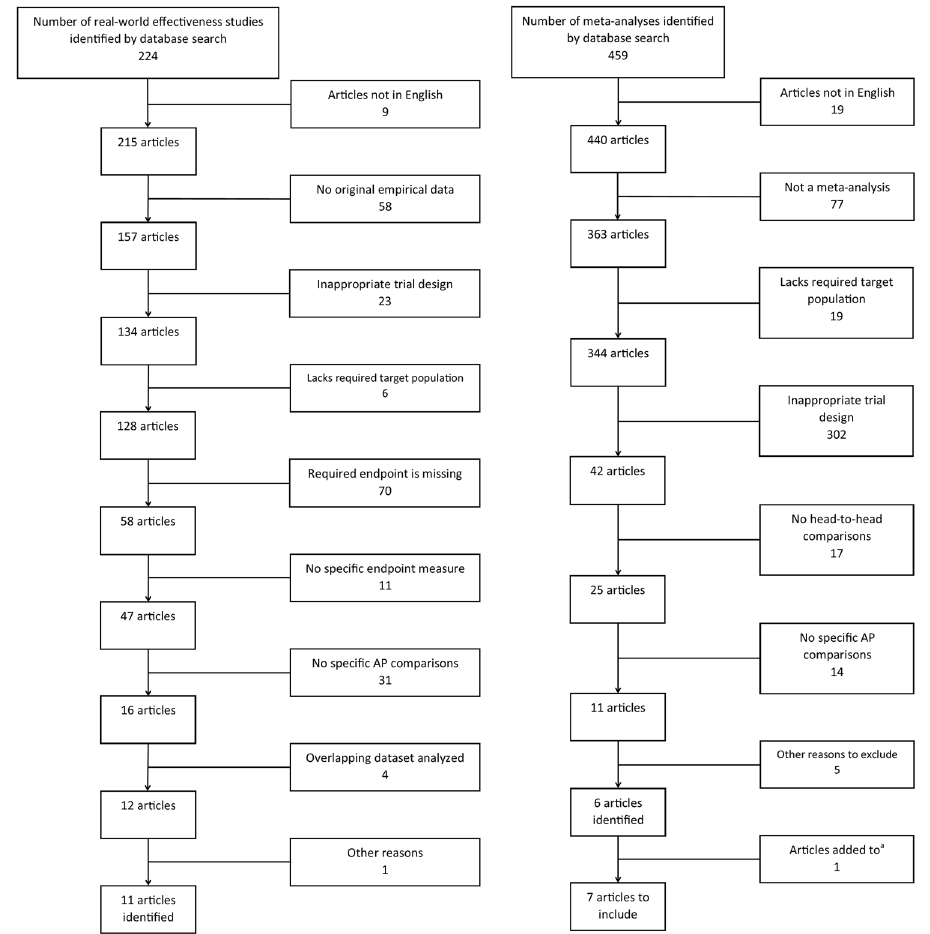
Fig. 1 Flow chart of selection process of real-world effectiveness studies (left panel), and previously published meta-analyses based on randomized clinical trials (right panel). a Article was identi fi ed during the review of selected papers: Sampson S, Hosalli P, Furtado VA, Davis JM; Risperidone (depot) for schizophrenia (Review); Cochrane Database Syst Rev